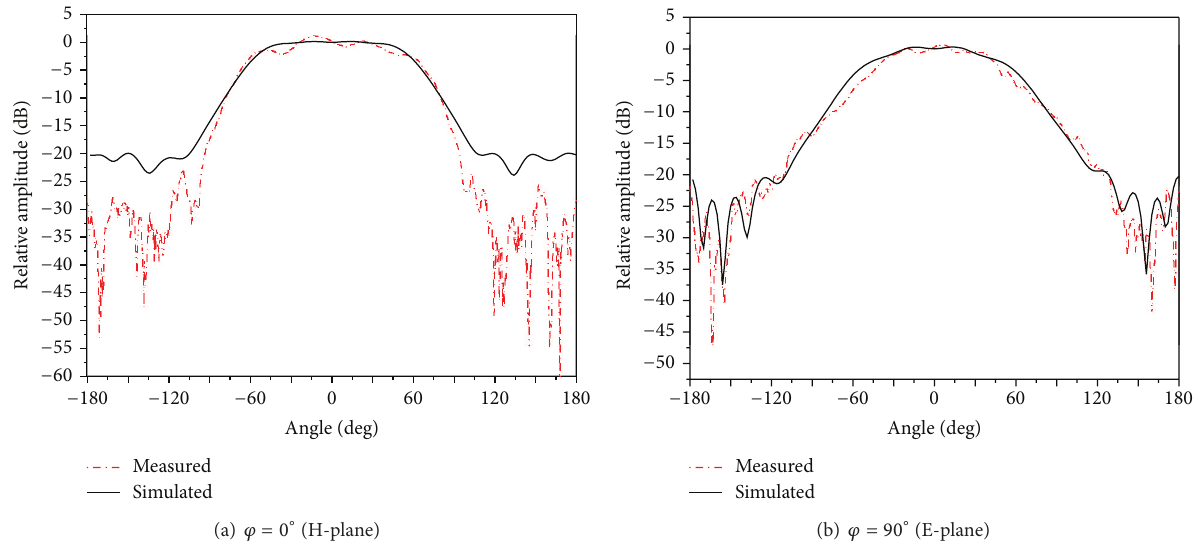
Figure 9: The active element pattern of central element R5-3 fed from port V.